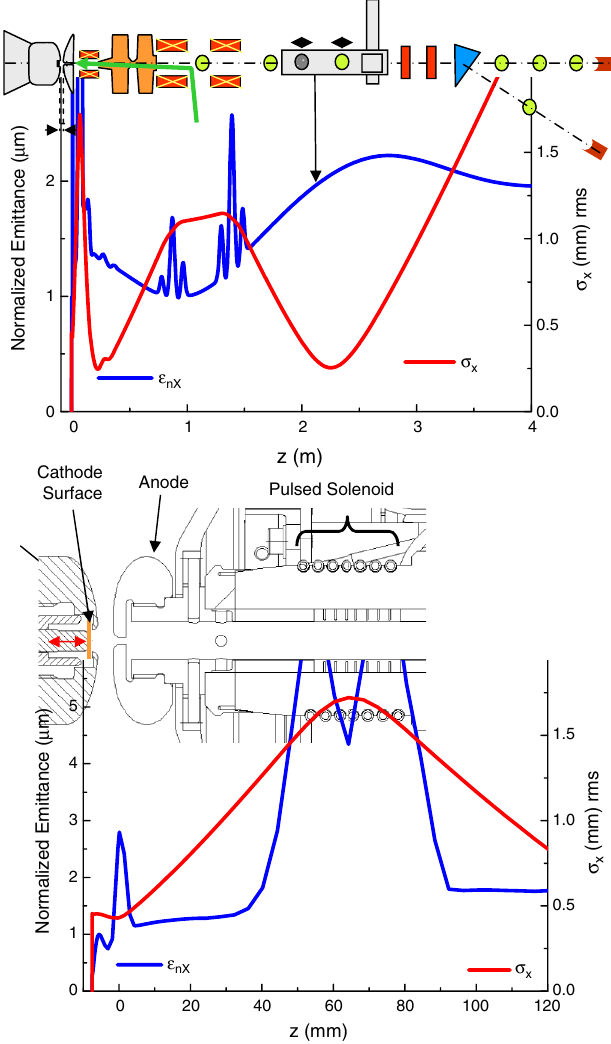
FIG. 5. ASTRA simulation of projected normalized emittance (90% charge) and transverse beam size (rms) versus z , over the first 120 mm (bottom graph) and over the full diagnostic line (top ¼ 300 kV ; gap ¼ 6 mm ; Gaussian time profile graph) ( V pulser ¼ 4 : 2 ps ; D ¼ 1 : 4 mm ; (cid:5) mc 2 ¼ 5 : 41 MeV ; 200 (cid:2) t; laser laser